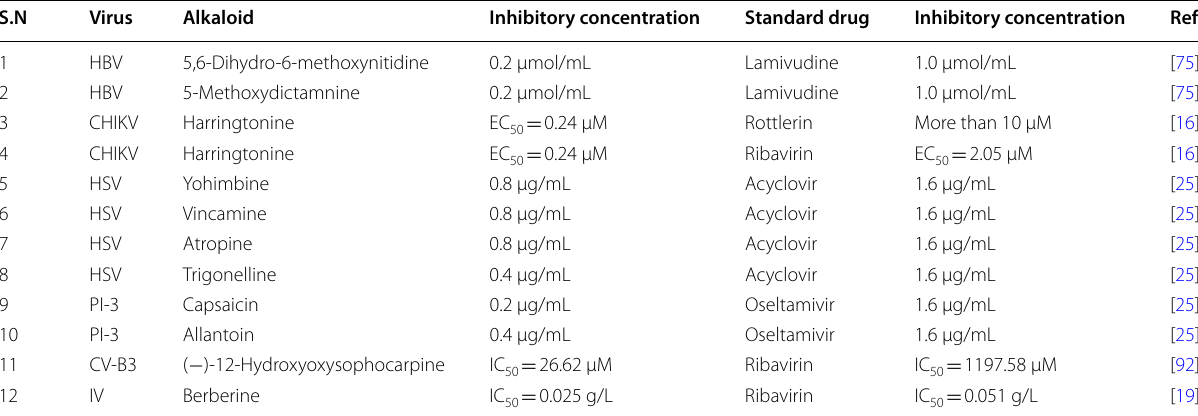
Table 2 Comparison of antiviral activities of alkaloids and standard drugs